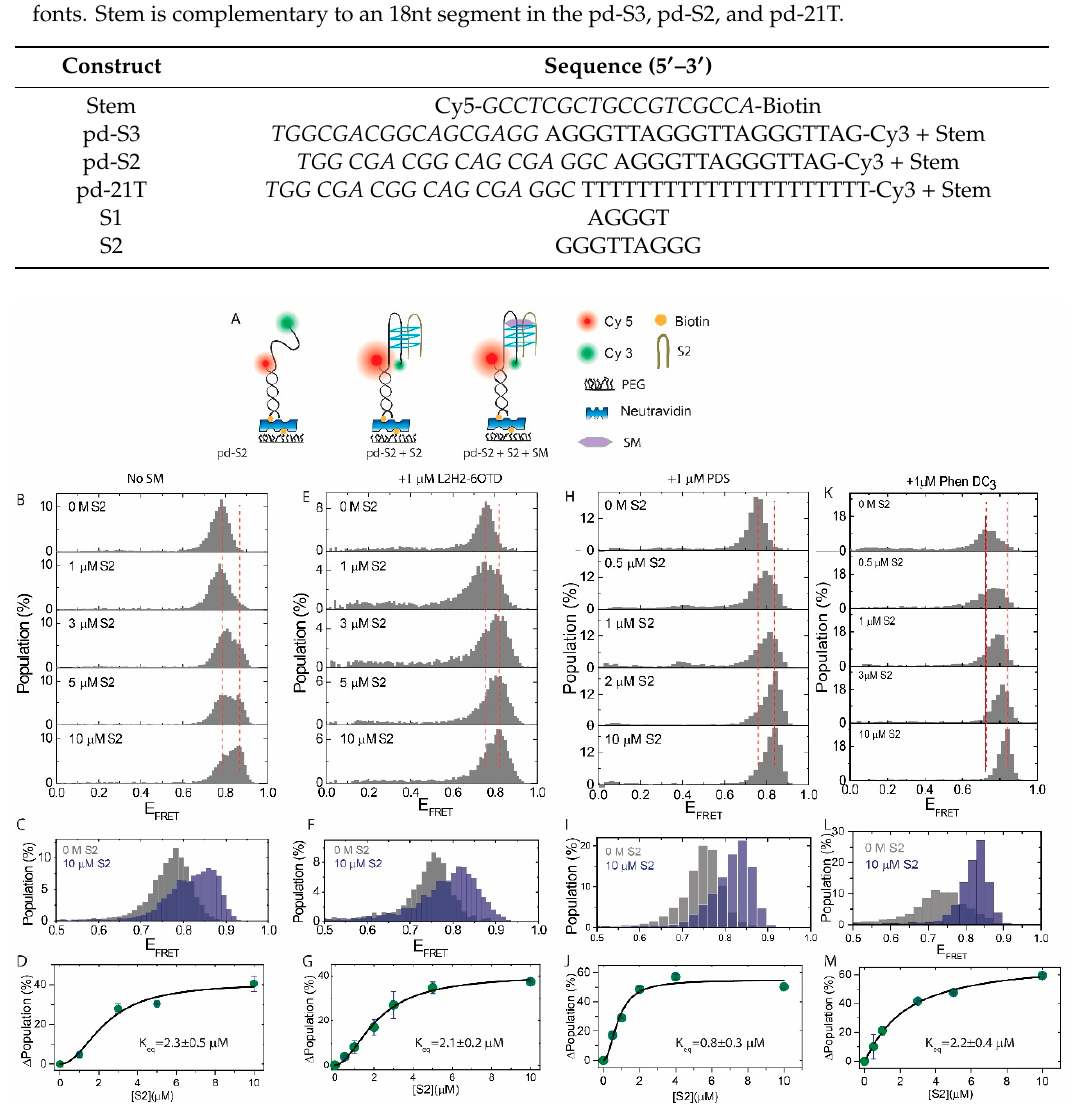
Figure 3. The e ff ect of SMs on i-GQ formation in 2 + 2 GGG-repeat configuration in 150 mM K + . ( A ) Schematic of the DNA constructs and the smFRET assay. ( B ) S2 was titrated from 0 M to 10 µ M in the absence of SM. Higher FRET states were populated in the FRET histogram as [S2] increased, suggesting i-GQ formation. The two red dashed lines indicated the peak of the FRET distribution at 0 M and 10 µ M S2. ( C ) 0 M and 10 µ M S2 data were overlaid to illustrate the shift. ( D ) Formation of i-GQ state was quantified by subtracting the FRET distribution at 0 M S2, from that at the corresponding [S2]. The cumulative of positive higher FRET population was plotted as a function of [S2]. The black line was a Hill function fit. ( E – G ) were identical to ( B – D ), respectively, except 1 µ M L2H2-6OTD was maintained in the chamber during S2 titration. ( H – J ) showed the same measurements in the presence of 1 µ M PDS, and ( K – M ) in the presence of 1 µ M Phen-DC 3 .